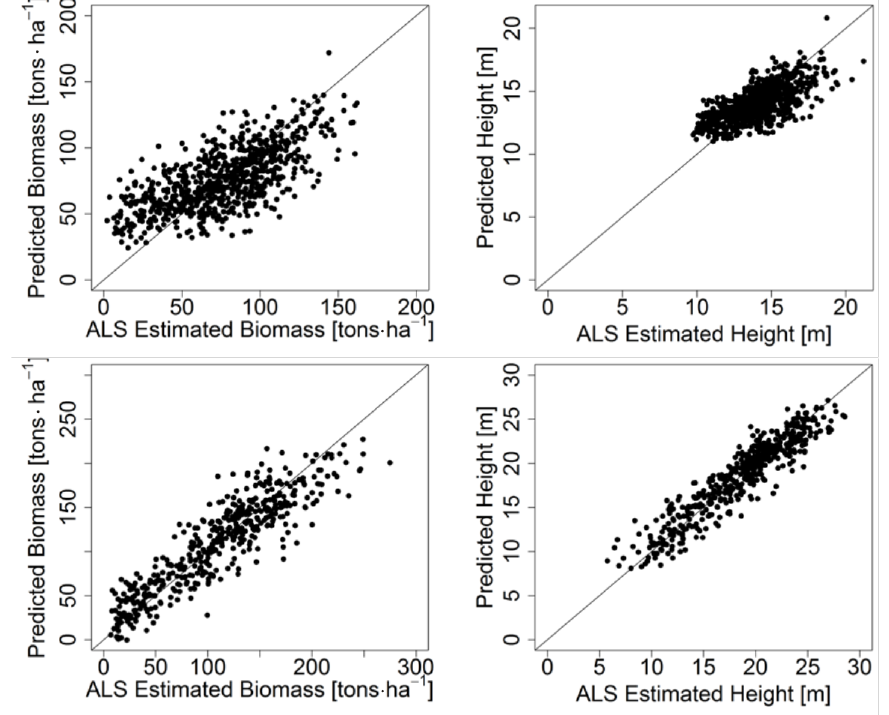
Figure 5. Scatter plots of AGB ( Left ) and H ( Right ) estimations for stands at the Krycklan ( Top ) and Remningstorp ( Bottom ) test